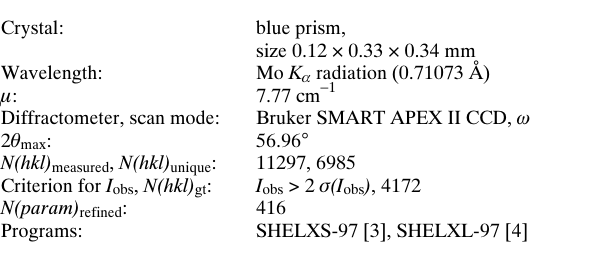
Table 1. Data collection and